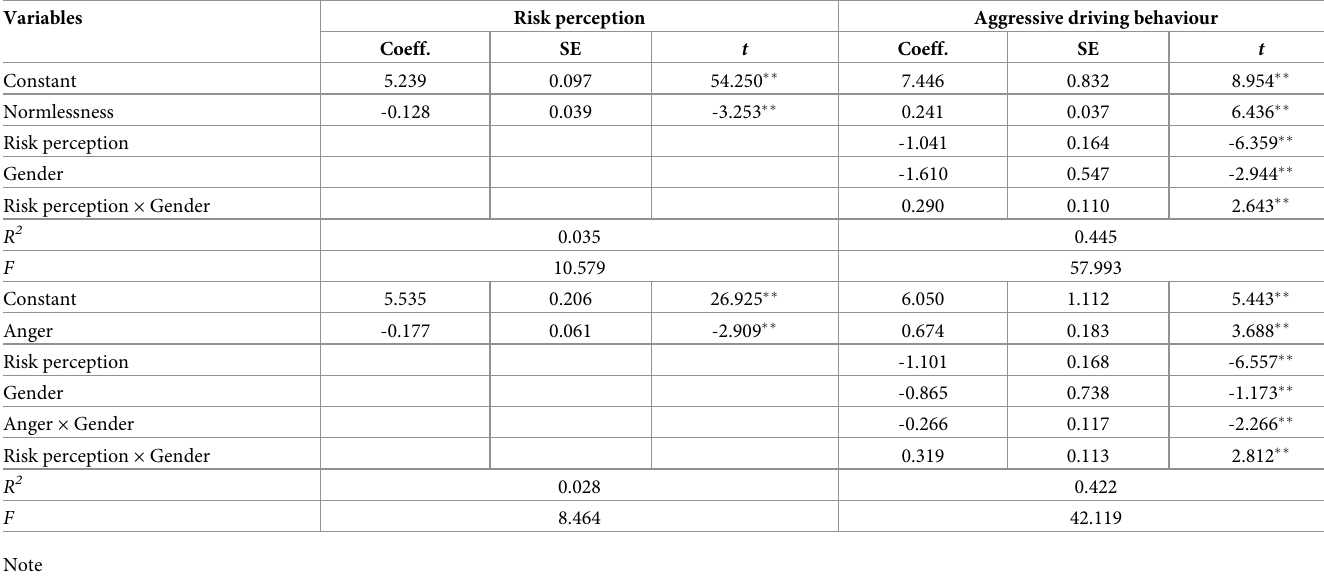
Table 5. Moderated mediation results of personalities on aggressive driving